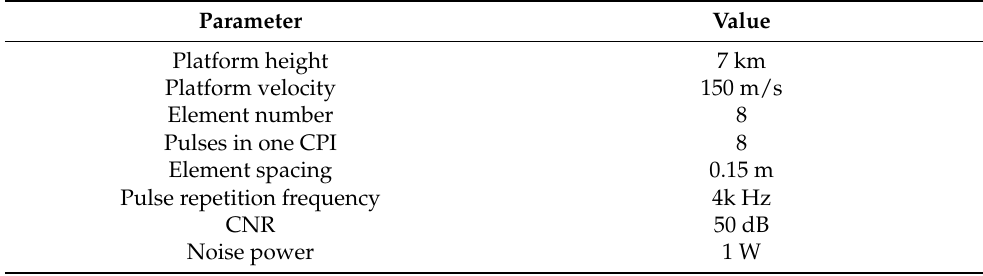
Table 1. Simulation parameters of the radar